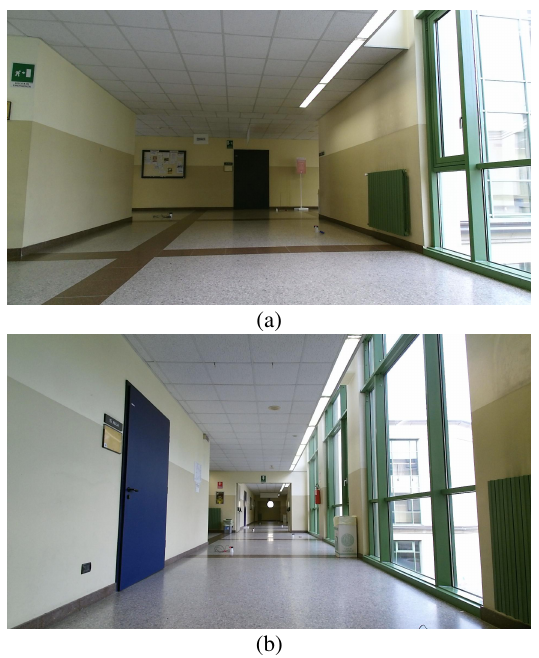
Figure 8. Critical areas: presence of large UWB range errors due to NLOS